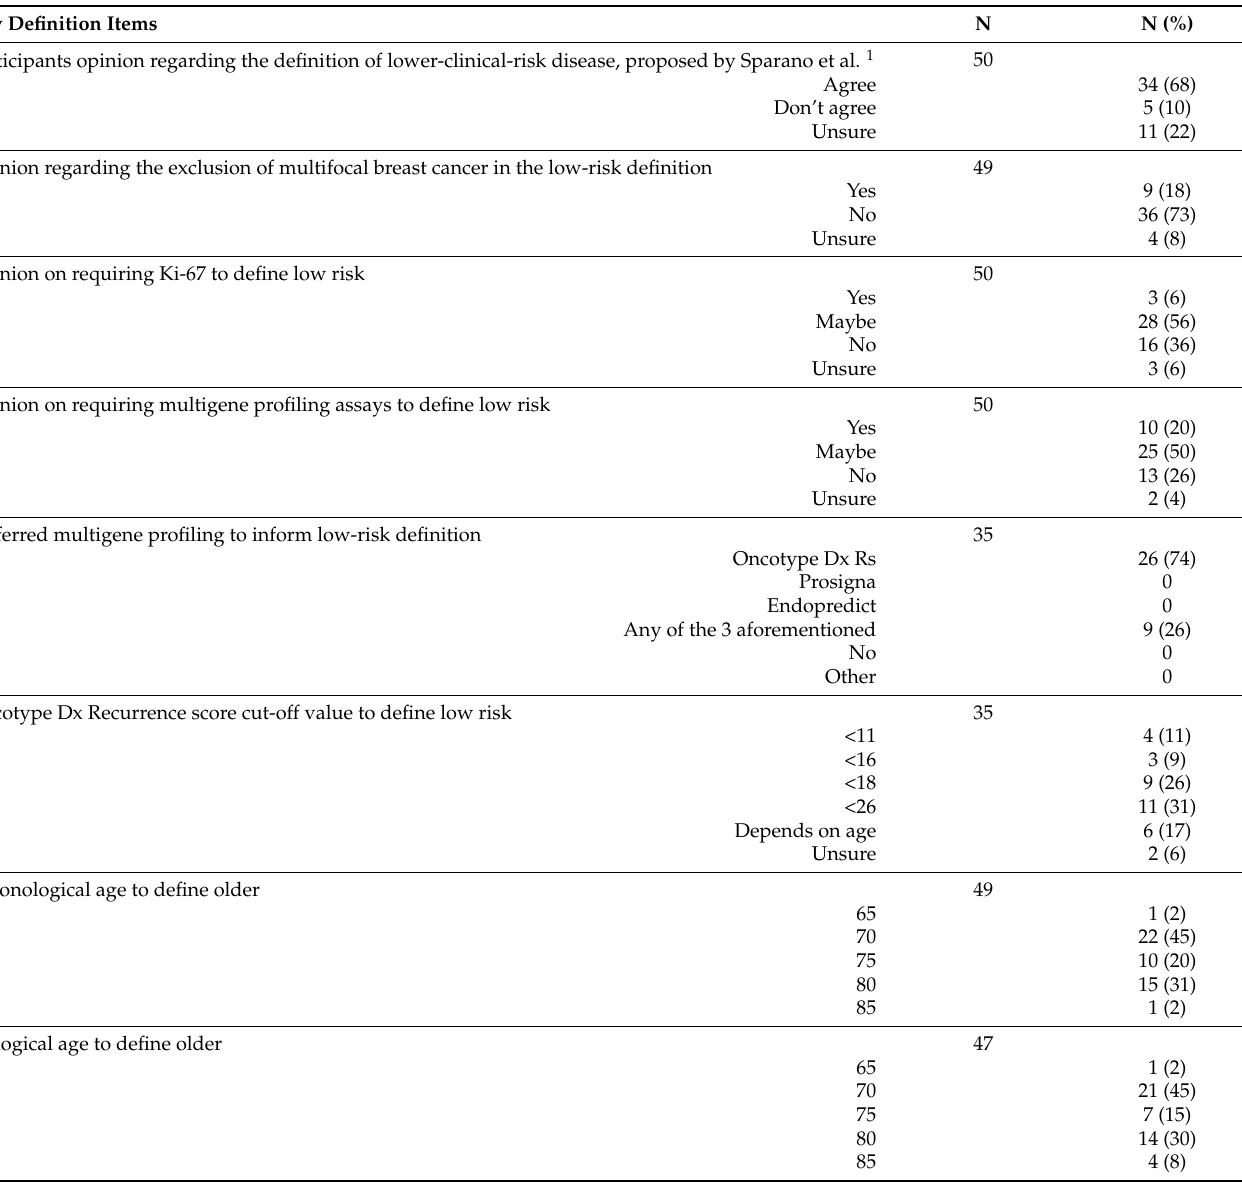
Table 2. Perception regarding definition of “low risk” ER+/HER2 − EBC and